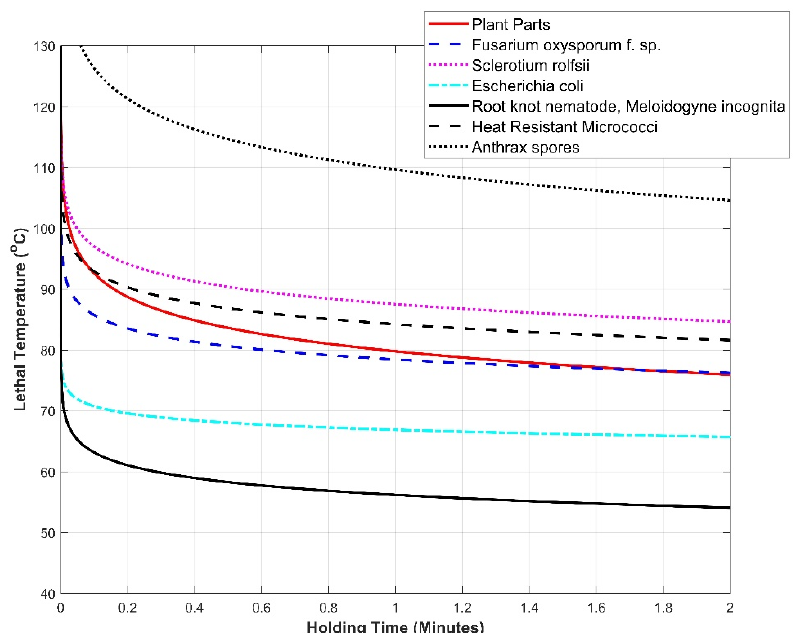
Figure 1. Lethal temperature as a function of holding time for several test species, based on empirical relationships developed in multiple studies [7–10] .